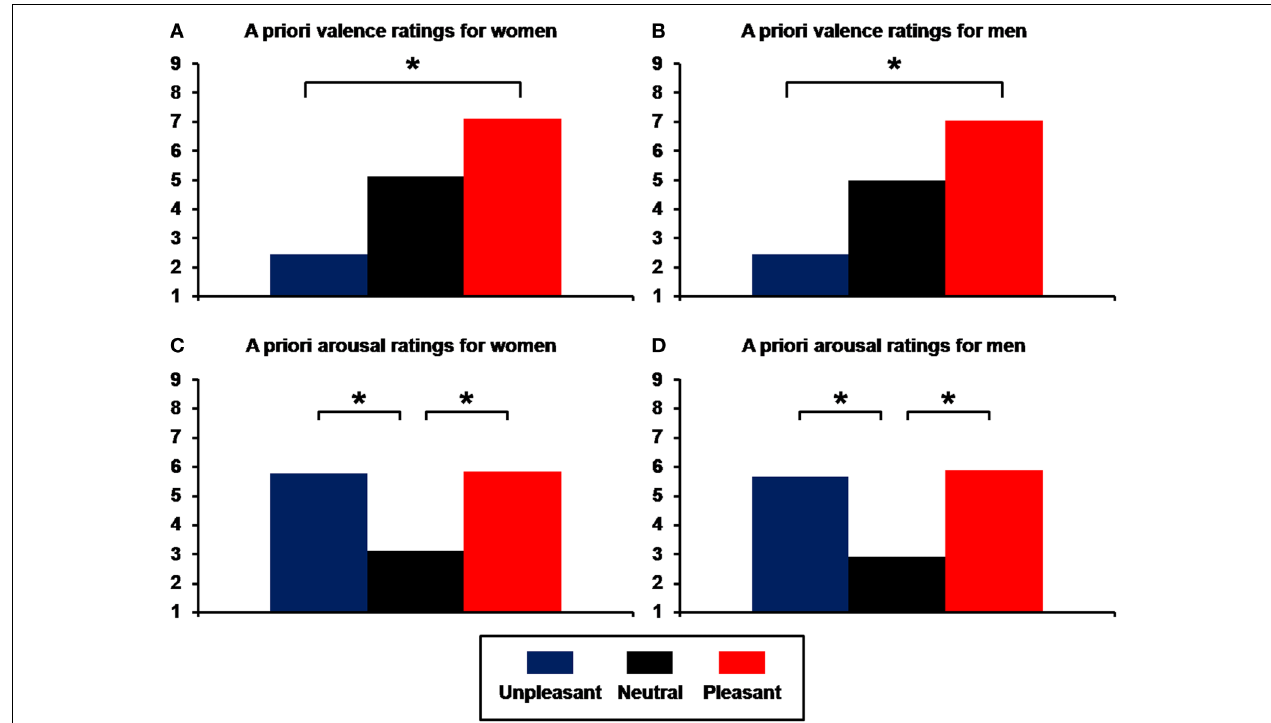
FIGURE 1 | Means of a priori ratings for unpleasant, neutral, and pleasant pictures selected from the International Affective Picture System (IAPS). (A) Valence ratings for women; (B) valence ratings for men; (C) arousal ratings for women; (D) arousal ratings for men (* p <